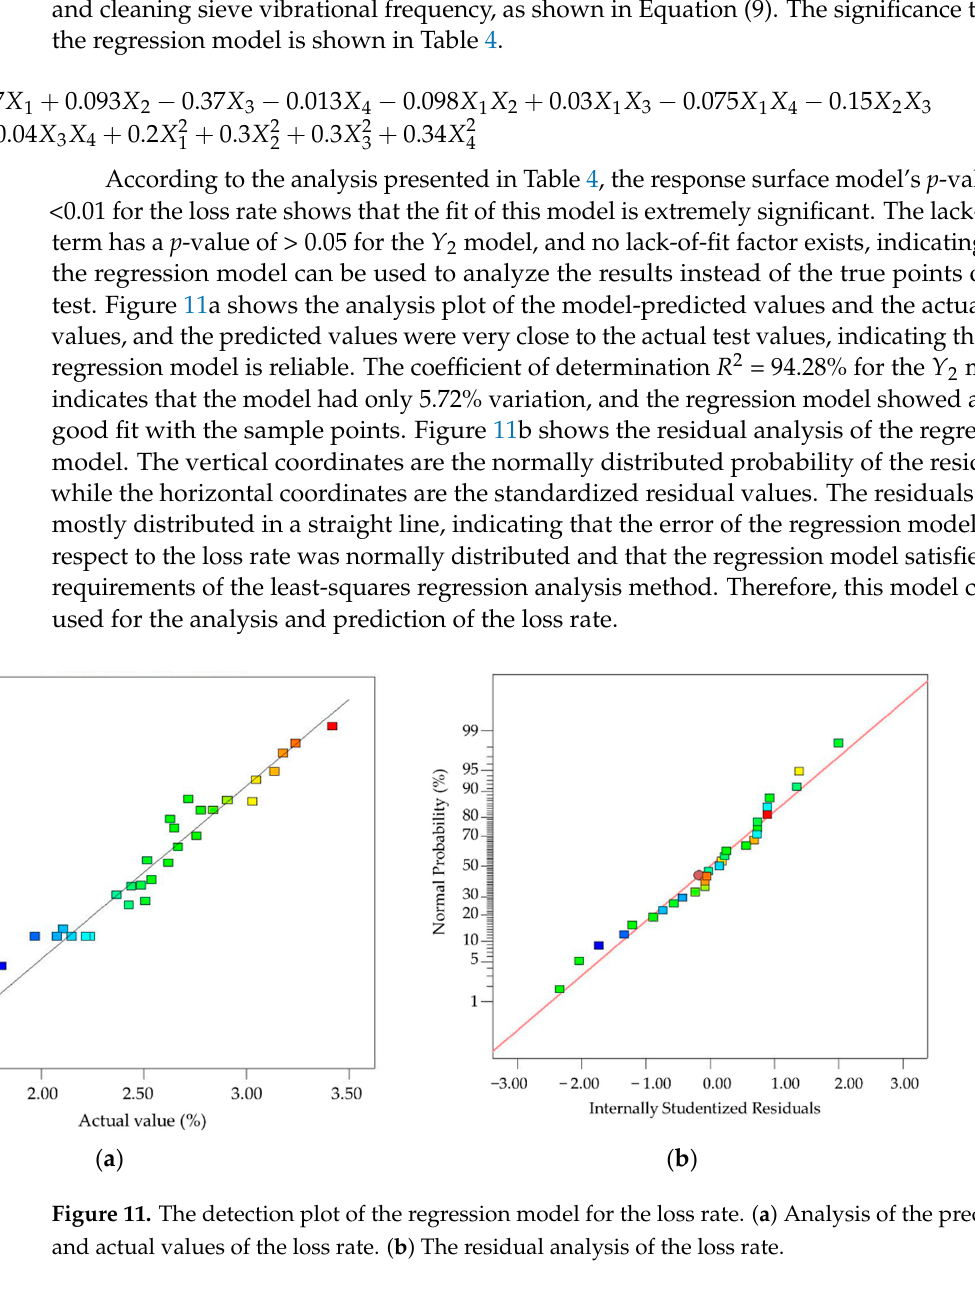
Establishment and significance test of the regression model of the loss rate Y 2